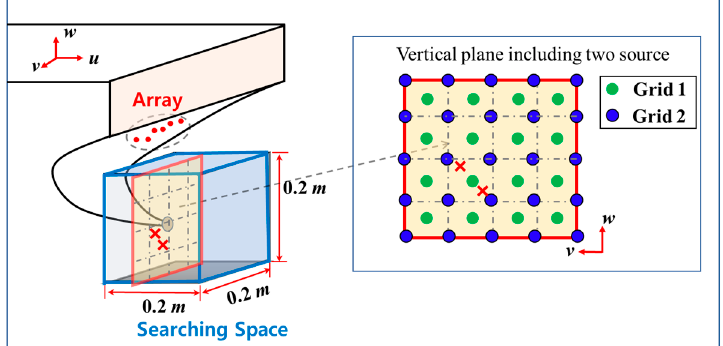
Figure 5. Numerical environment for examining the proposed localization method. Two adjacent noise sources were simulated emitting spherical sound waves, which were measured by an array located at the upper side of the search space. The amplitudes of the noise sources were set as the same on purpose in order to inspect the resolutions of considered schemes conveniently.